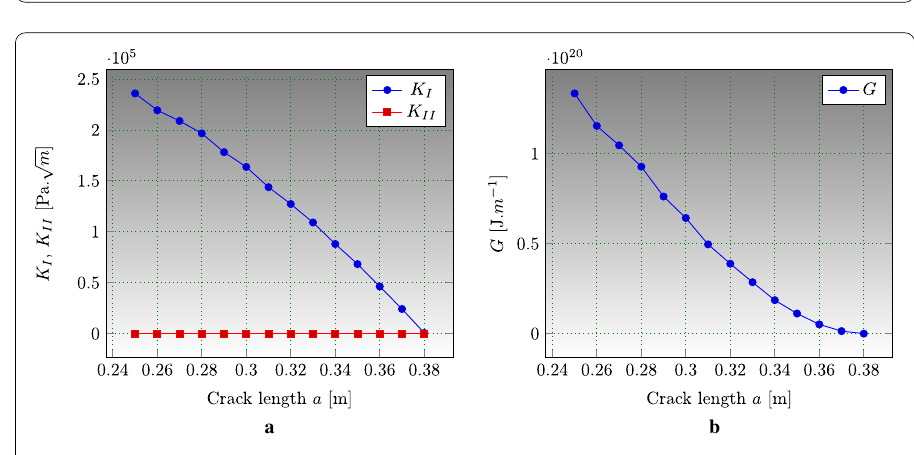
Fig. 21 Crack growth in edge cracked strip: a stress intensity factors K I and K II , b energy release rate G